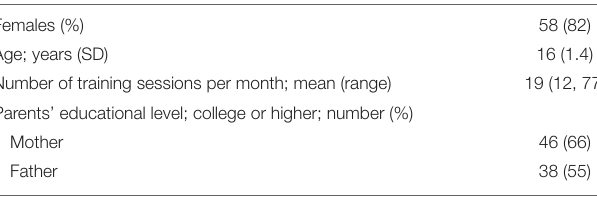
TABLE 1 | Demographic and clinical characteristics among the participating adolescents with EILO a